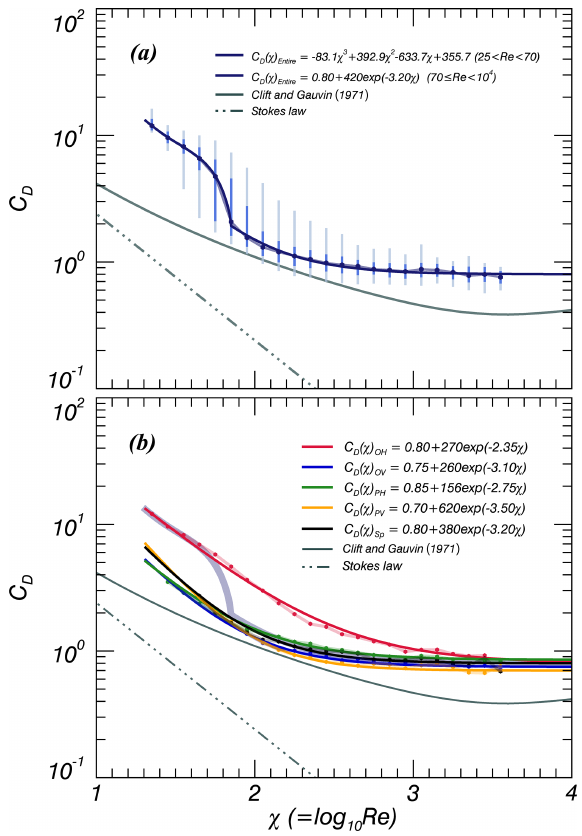
Figure 11. Same as Fig. 9 but for Reynolds number ( Re ) and drag coefficient ( C D ). The solid grey and broken grey lines in (a) are the relationships of spheres suggested by Clift and Gauvin (1971) and Stokes (1851), respectively.